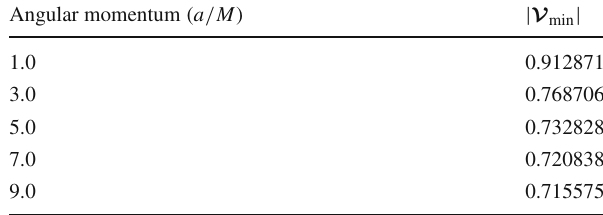
Table 1 The numerical value of the minimum velocity | V min | intro- duced above is of importance to the energy extraction process. In this table we have provided numerical estimates for the minimum velocity | V | with l = a and various choices of the ratio a / M . As evident min for larger values of a / M , the minimum velocity decreases from being unity Angular momentum ( a / M